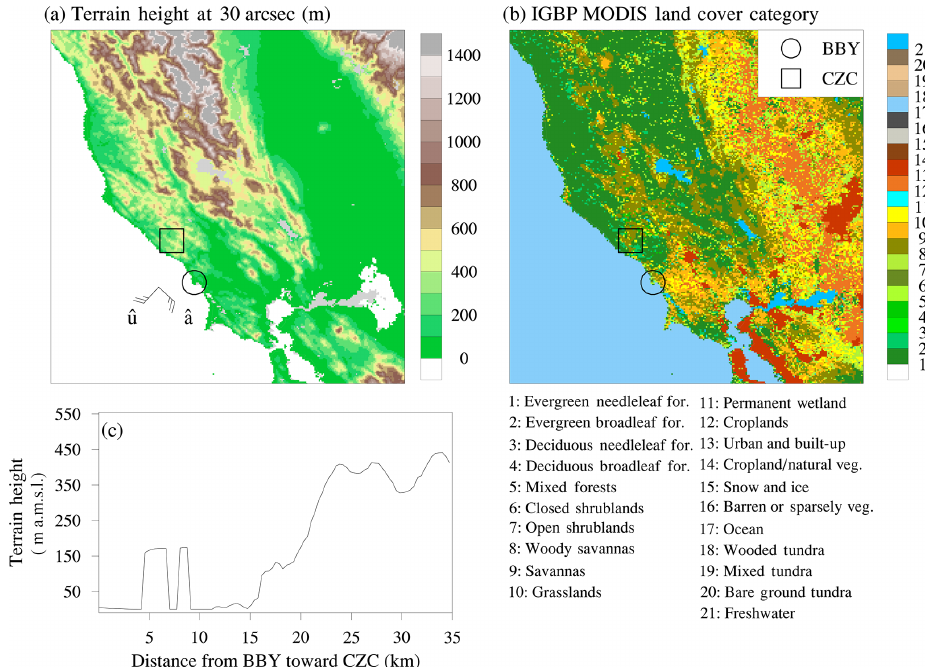
Figure 1. (a) Plan view of regional terrain height (m – color fill) from the USGS 30arcsec digital elevation map. Annotations are centered on BBY (circle) and CZC (square) and depict theoretical wind barbs aligned with the upslope ( ˆ u ) and along-slope directions ( ˆ u ). (b) As in (a) , except the dominant category from the IGBP MODIS land use database is depicted (color fill – see legend for category name). (c) Transect of terrain height (ma.m.s.l.) along a great circle path from BBY to